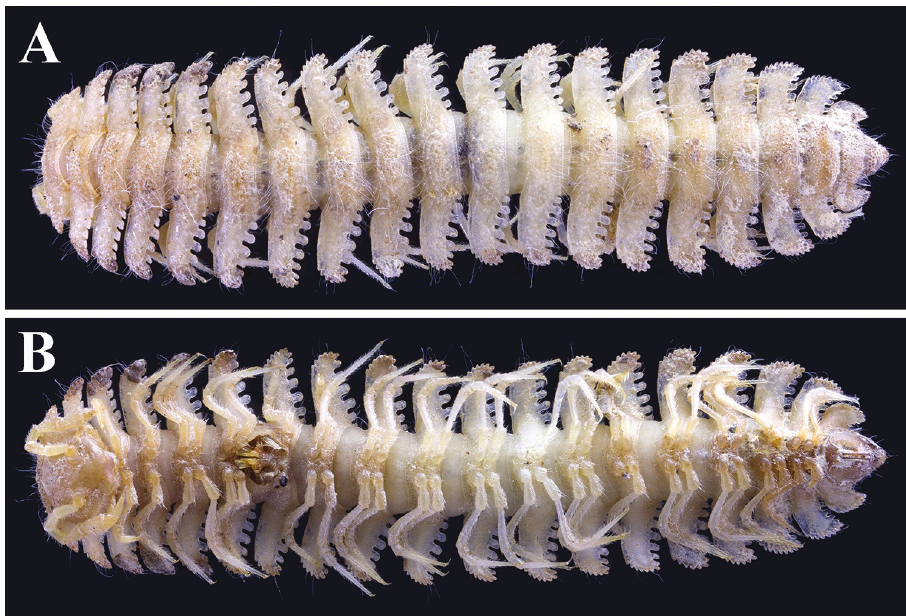
Figure 1. Trichopeltis bellus sp. n., ♂ holotype. A–B habitus, dorsal and ventral views, respectively.